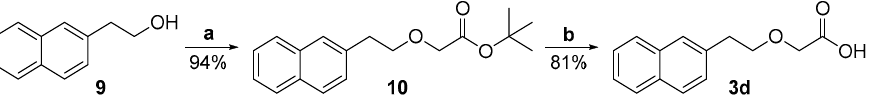
Figure 4. Synthesis of compound 3d . (a) BrCH 2 COOC(CH 3 ) 3 , Bu 4 NHSO 4 , 50% NaOH, toluene; (b) 50% TFA, dry CH 2 Cl 2 .